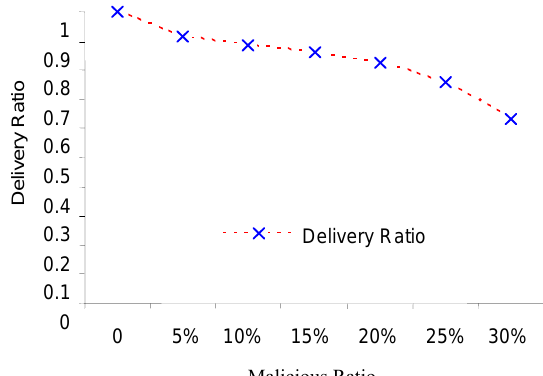
Figure 8 . NRFP : Black Hole and Selective attacks run with seven scenarios implemented according to the number of malicious nodes on the network. The energy consumption of each sensor node [17] is as follows: Ea=100 pJ/bit/m2, Ee = 50 nJ/bit and Ec = 5 nJ/bit where consumed for transmitting , receiving and listening respectively each sensor needs to send a packet of length R = 400 bits to the cluster head on random time. Cluster head period T is set as 2,000 s, and the execution time of task is set as = 0.005 s. The data packet size is 2 KB and the sensing range to 64